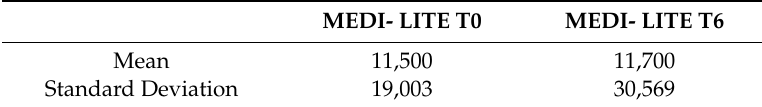
Table 3. Results of the questionnaires on adherence to the Mediterranean diet measured by the MEDI-LITE